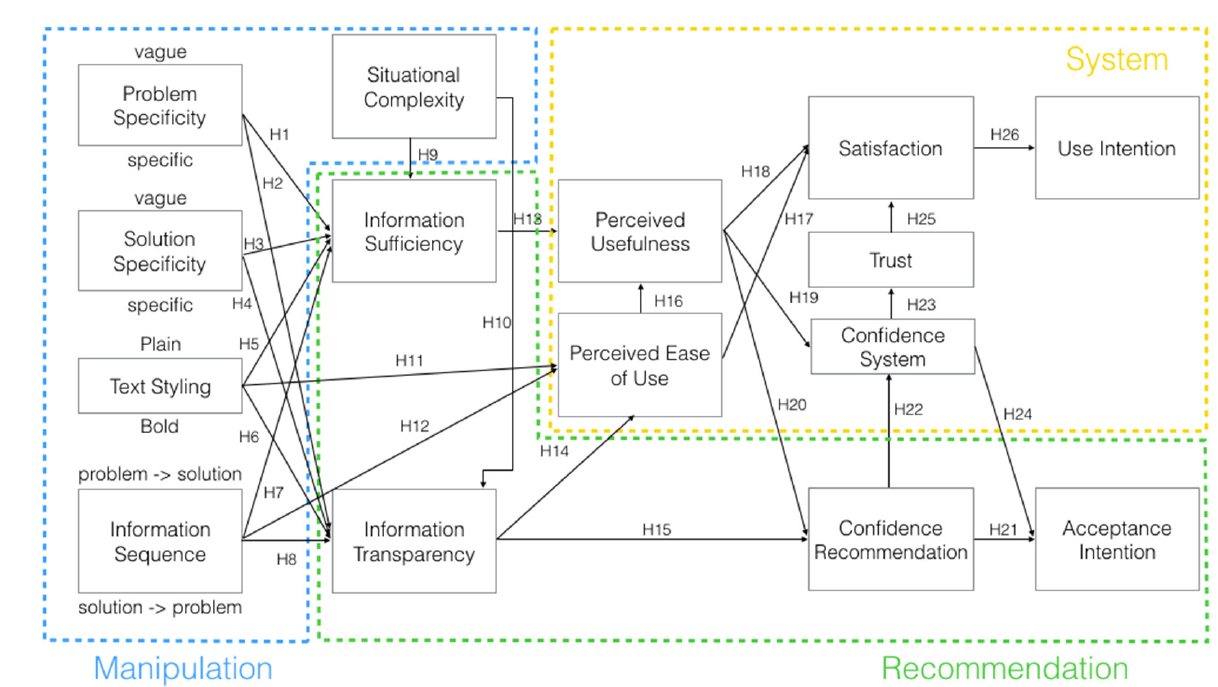
Figure 1. Proposed self-reported research model.